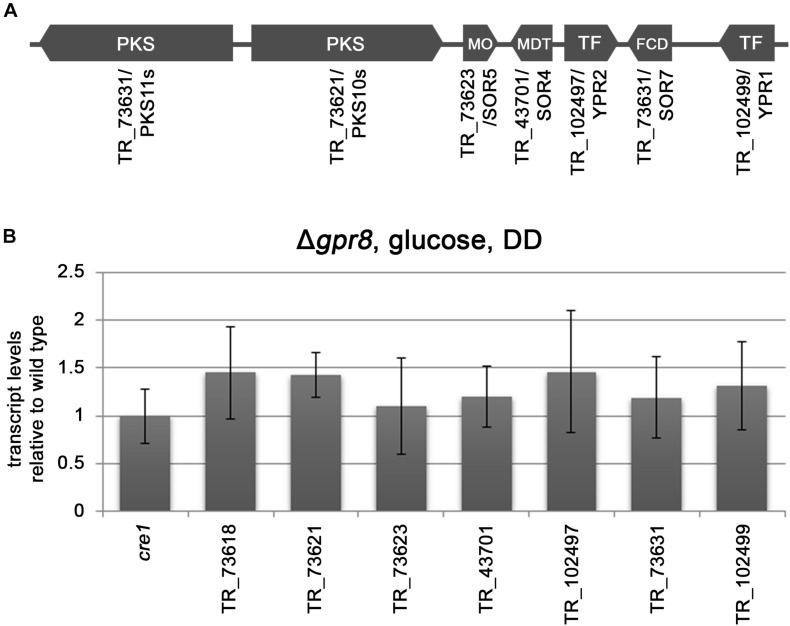
Transcript levels of cre1 and SOR cluster related genes in Δgpr8 in darkness on glucose. (A) Schematic representation of the SOR cluster of T. reesei with protein IDs as listed on JGI (http://genome.jgi.doe.gov/Trire2/Trire2.home.html) along with gene designations. SOR7/TR_73631 was named SOR4 in Derntl et al. (2017a). (B) Transcript levels of cre1 and SOR cluster assigned genes in Δgpr8 relative to wild type grown on 1% (w/v) glucose in darkness (DD). Transcriptional changes shown are non-significant (p-value > 0.05) and were analyzed in three biological replicates.